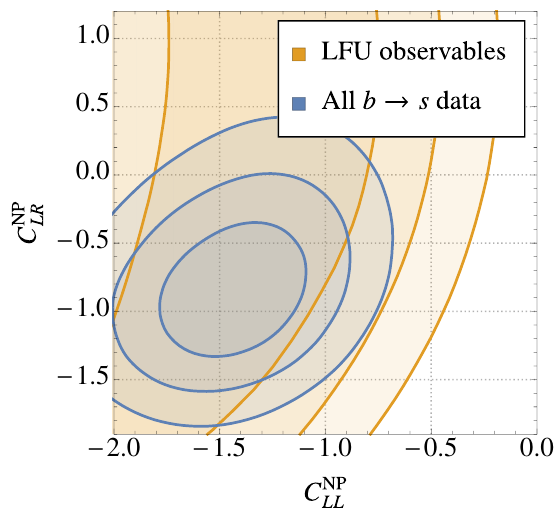
Figure 4. Figure 1 in ref. [16] translated into the chiral basis. The (cid:12)gure shows the allowed 1, 2 and 3 (cid:27) contours in the C NP { C NP plane. The orange contours represent the (cid:12)t to only LFU LL LR observables while the blue contours take into account all b ! s observables including the branching + e (cid:0) [88]. ratios of B ! (cid:22) + (cid:22) (cid:0) and the BaBar measurement of B ! X s s e of the Yukawa couplings y , while C (cid:30) (cid:25) (cid:0) 1 : 2 requires large leptoquark couplings to the 2 i LL second and third generation of left-handed quarks for the second term in eq. (3.8a) | corresponding to the second diagram in (cid:12)gure 3 | to dominate over the (cid:12)rst, since it alone can be